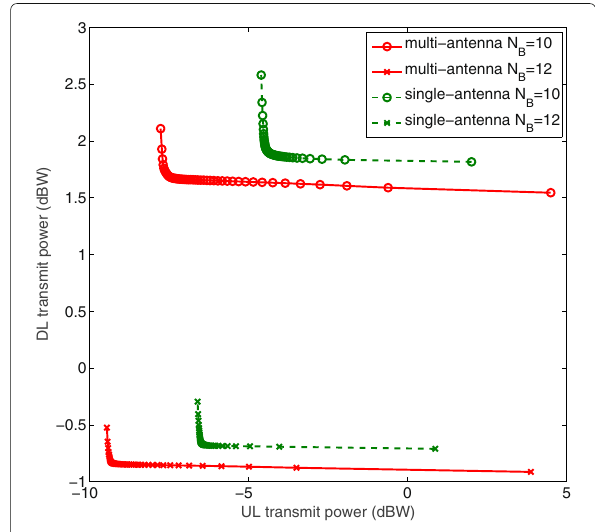
Fig. 1 Trade-off region between UL and DL transmit powers for different number of transmit and receive antennas